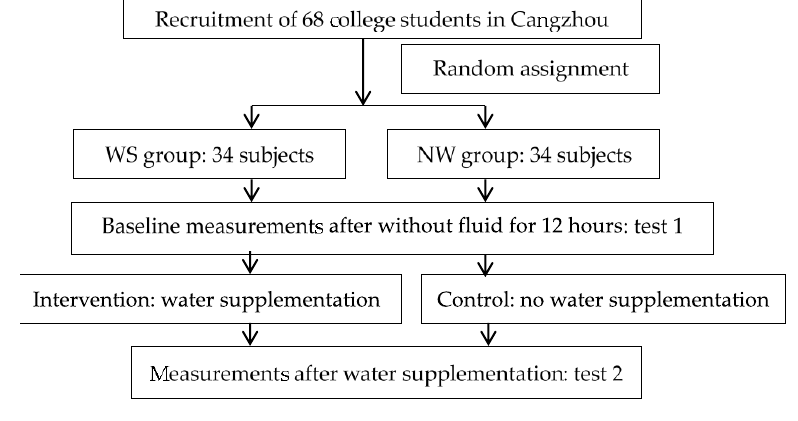
Figure 1. Flow diagram of study design.